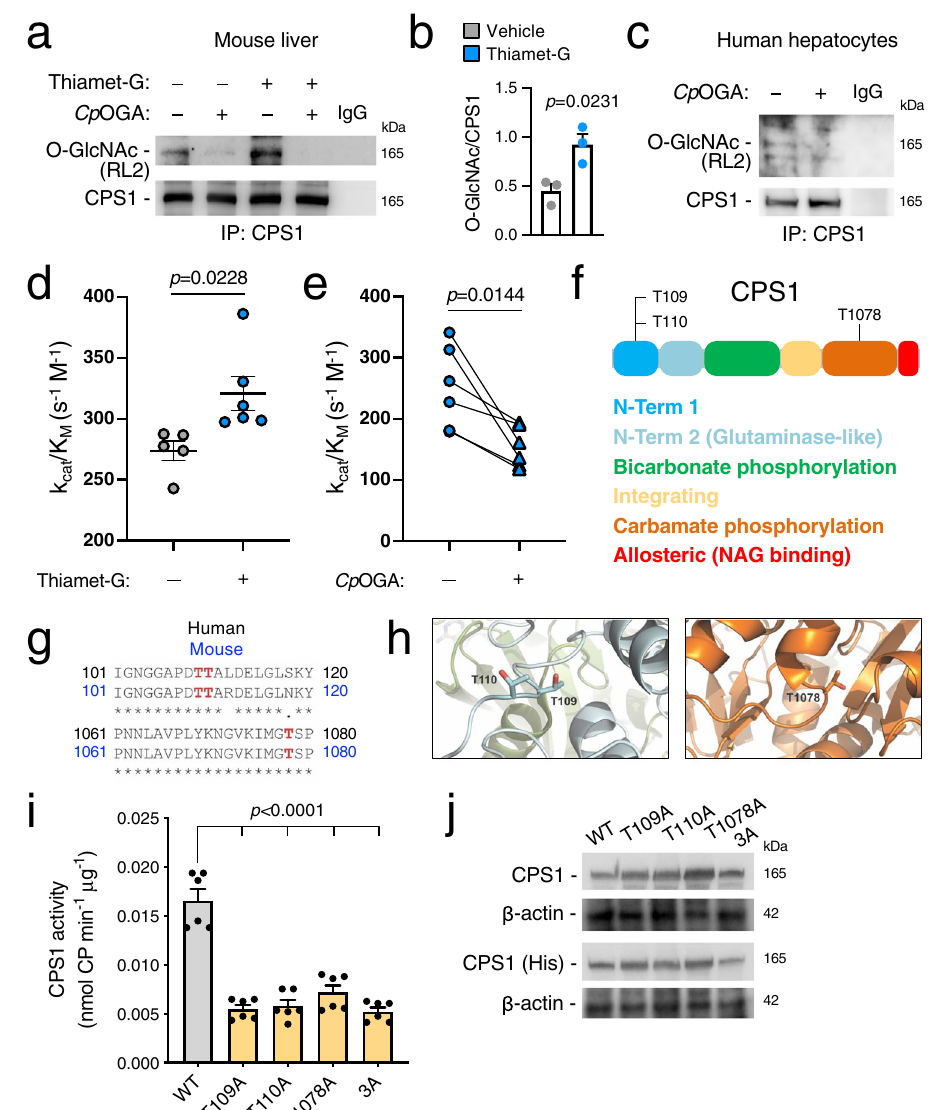
Fig. 4 | CPS1 O-GlcNAcylation improves enzyme kinetics for ammonia. a Immunoprecipitated CPS1 is O-GlcNAcylated in livers of C57BL/6 wild-type (WT) mice i.p. injected with vehicle (PBS) or Thiamet-G (40mg/kg for 2 days). Pre- incubation of liver lysates with the bacterial OGA orthologue from Clostridium perfringens ( Cp OGA)thatspeci fi callyremovestheO-GlcNAcresultedinlossofCPS1 immunoreactivity detected by the anti-O-GlcNAc antibody (RL2). b Densitometric quanti fi cations of bands detected with the O-GlcNAc antibody on immunopreci- pitatedCPS1.Dataarerepresentativeofthreeindependentexperiments. p =0.0231 (Unpaired t -test). c Immunoprecipitated CPS1 is O-GlcNAcylated in human hepa- tocytes. d CPS1 speci fi city constant (kinetic ef fi ciency) for ammonia measured in livers harvested from WT mice after treatment with Thiamet-G (40mg/kg, i.p. for 2 days) ( n =6 mice/group) or vehicle ( n =5 mice/group). p =0.0228 (Unpaired t - test). e Analysisof CPS1kineticef fi ciency for ammonia inliversof WT mice